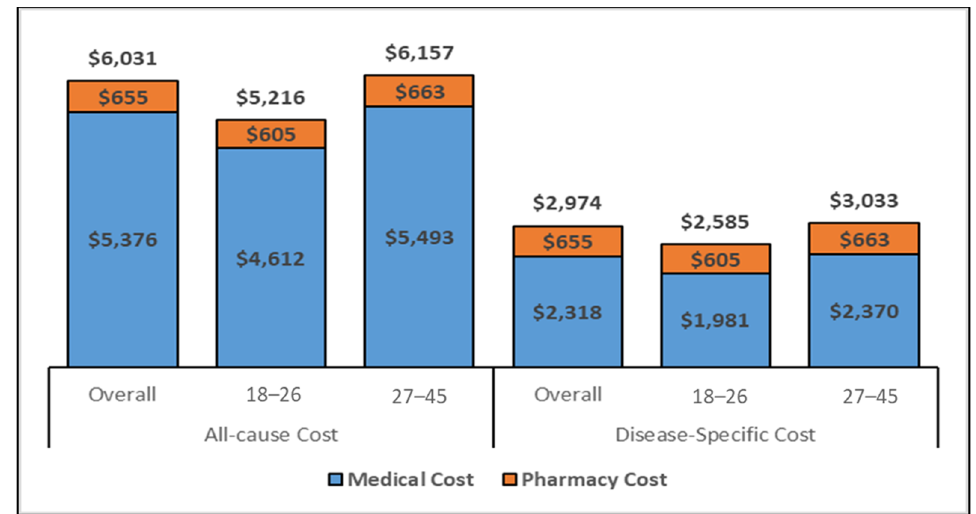
Figure 3. All ‐ cause and disease ‐ specific PPPY costs for the overall cohort (Inflated to 2020 USD) Figure 3. All-cause and disease-specific PPPY costs for the overall cohort (Inflated to 2020 USD)